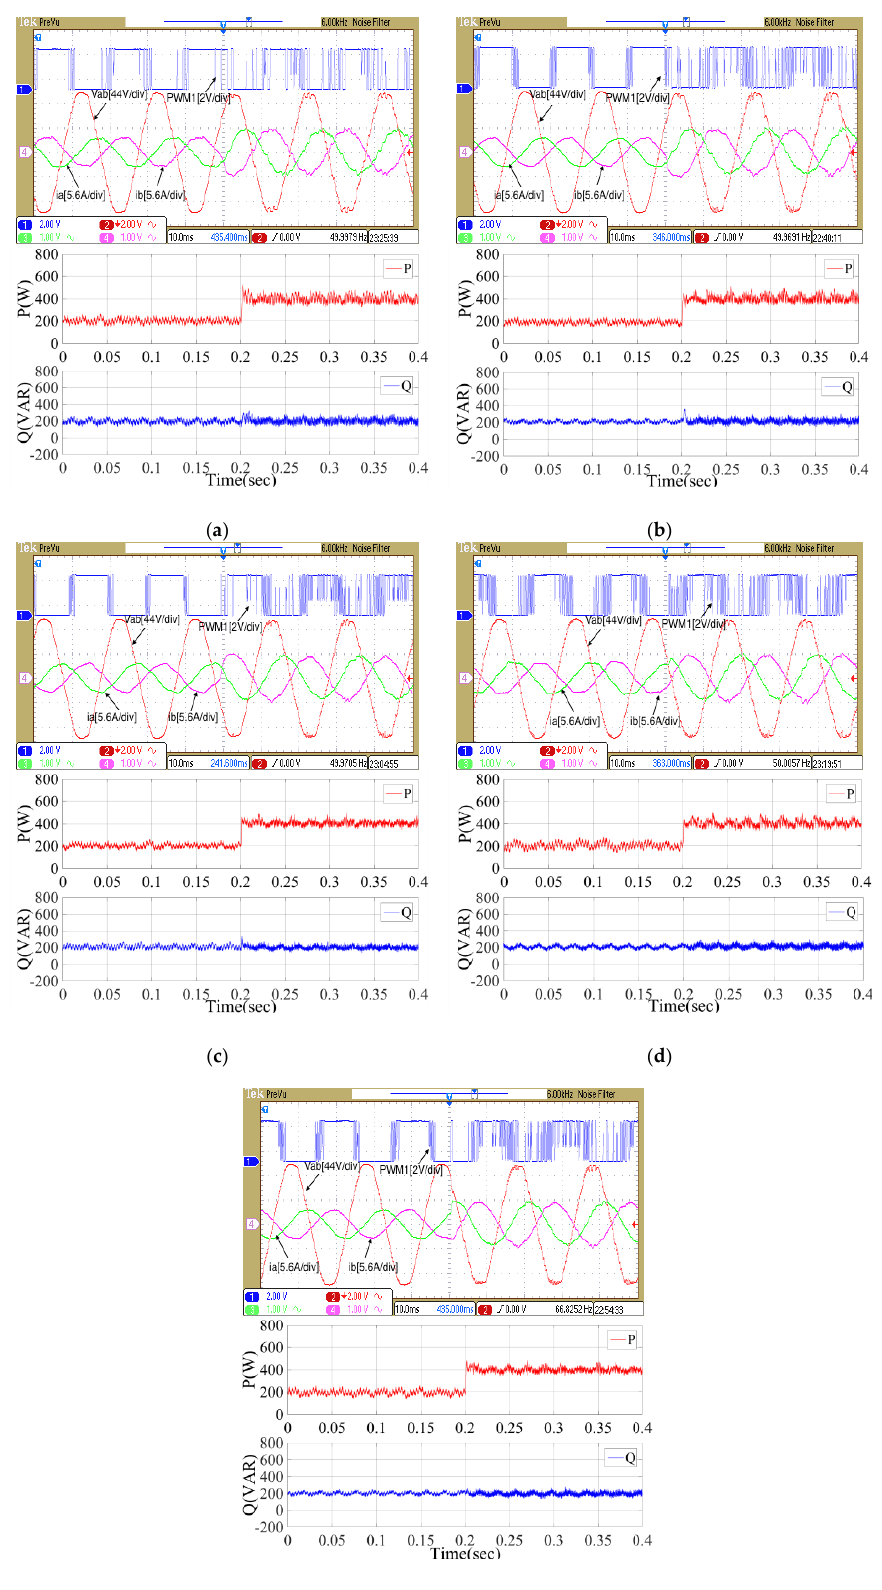
Figure 10. Experimental results when Q = 200 Var, P changes from 200 W to 400 W. Top: PWM signal, V ab , i a and i b . Bottom: active and reactive power. ( a ) CDPC. ( b ) CMPC-I. ( c ) CMPC-II. ( d ) MMPC-I. (e) MMPC-II. Table 4. Quantitative Comparison of Steady-State and Dynamic-State Performance in Experiment.